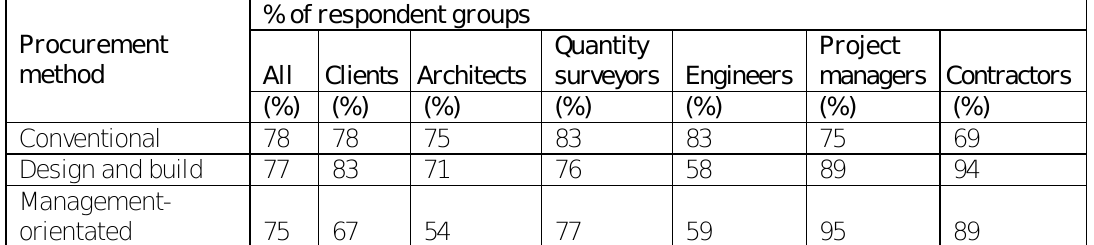
Table 3: Perceptions of whether all or most building projects are completed within the client’s agreed budget (building cost) for the project